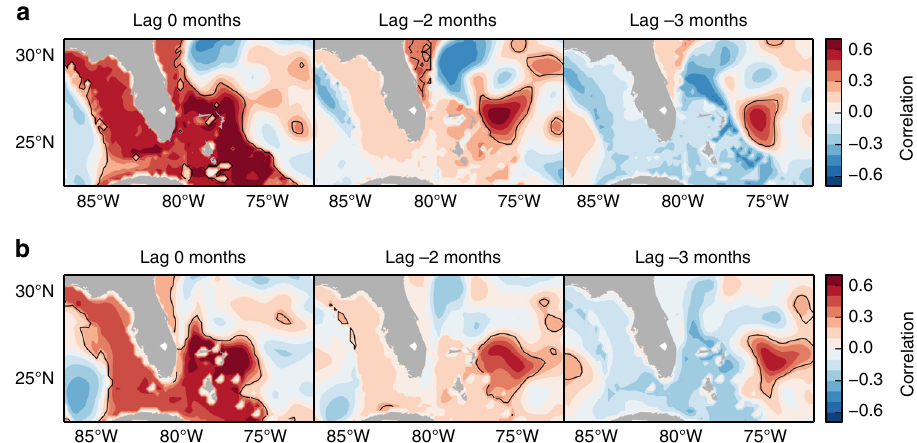
Fig. 6 Lagged correlation maps of the steric contribution from below the seasonal thermocline. Point-wise lagged correlation of the steric contribution from 200 to 1000m depth at the continental slope east of the Bahamas with that at each grid point for a OCCAM and b NEMO. Steric time series have been band-pass fi ltered (Butterworth fi lter with lower and higher cutoff frequencies: 1/16 and 1/8 months – 1 ) to focus on the frequencies relevant to the SLAC modulator. For grid points in shallow areas (<200 m), the correlation is computed with the SLAC modulator instead of the steric. Negative lags indicate that steric changes at the slope east of the Bahamas lag relative to other grid points. Black line denotes signi fi cance of positive correlations at the